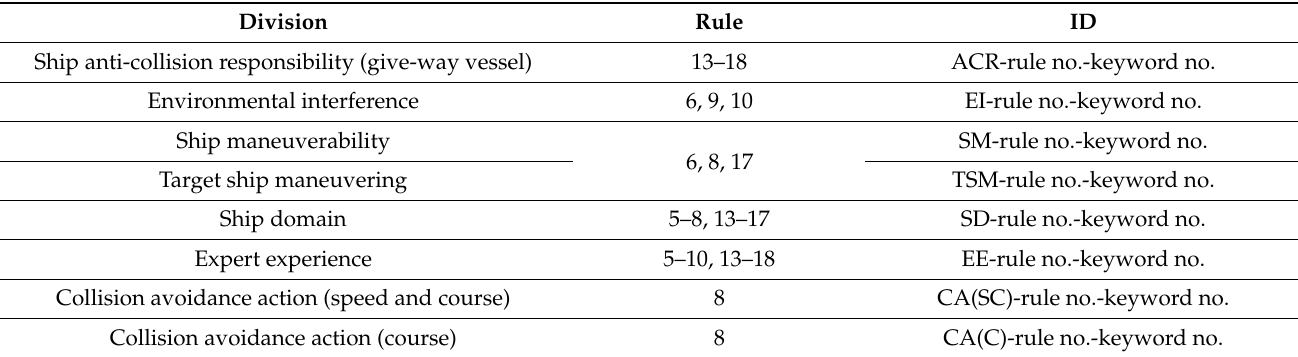
Table 10. Allocation of requirements ID.